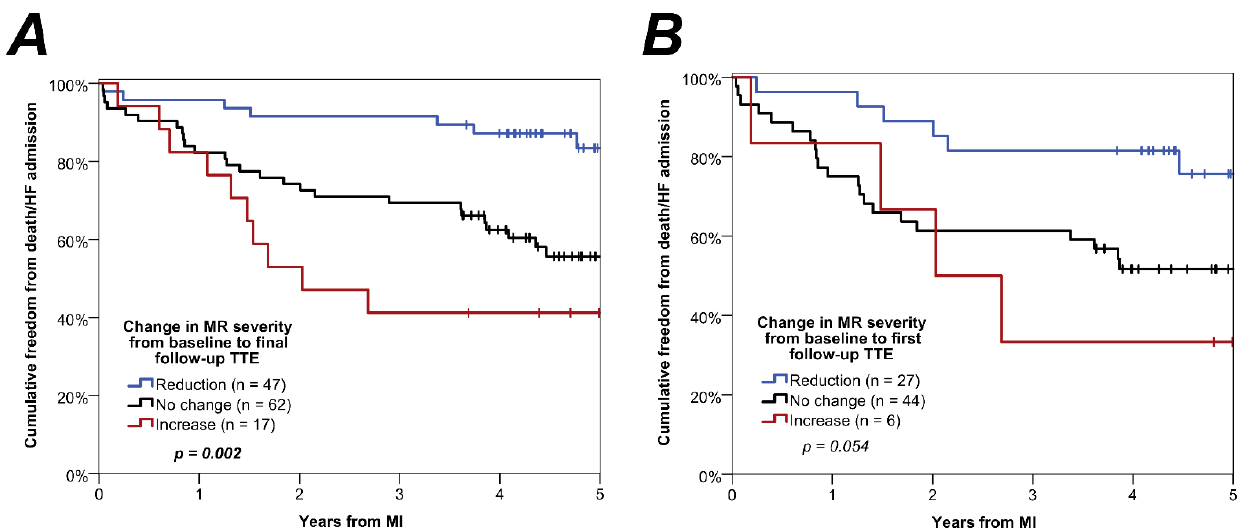
Figure 4. Kaplan–Meier curves of freedom from death/heart failure admission by change in MR severity. ( A ) groups all patients by the change in MR severity from the baseline TTE to the final follow ‐ up TTE. ( B ) only includes those patients where the first follow ‐ up TTE was within 1 year of the baseline TTE ( n = 77), and groups these by the change in MR severity from baseline to the first follow ‐ up TTE. p ‐ Values are from univariable Cox regression models. HF = heart failure; MI = myocardial infarction; MR = mitral regurgitation; TTE = transthoracic echocardiography.